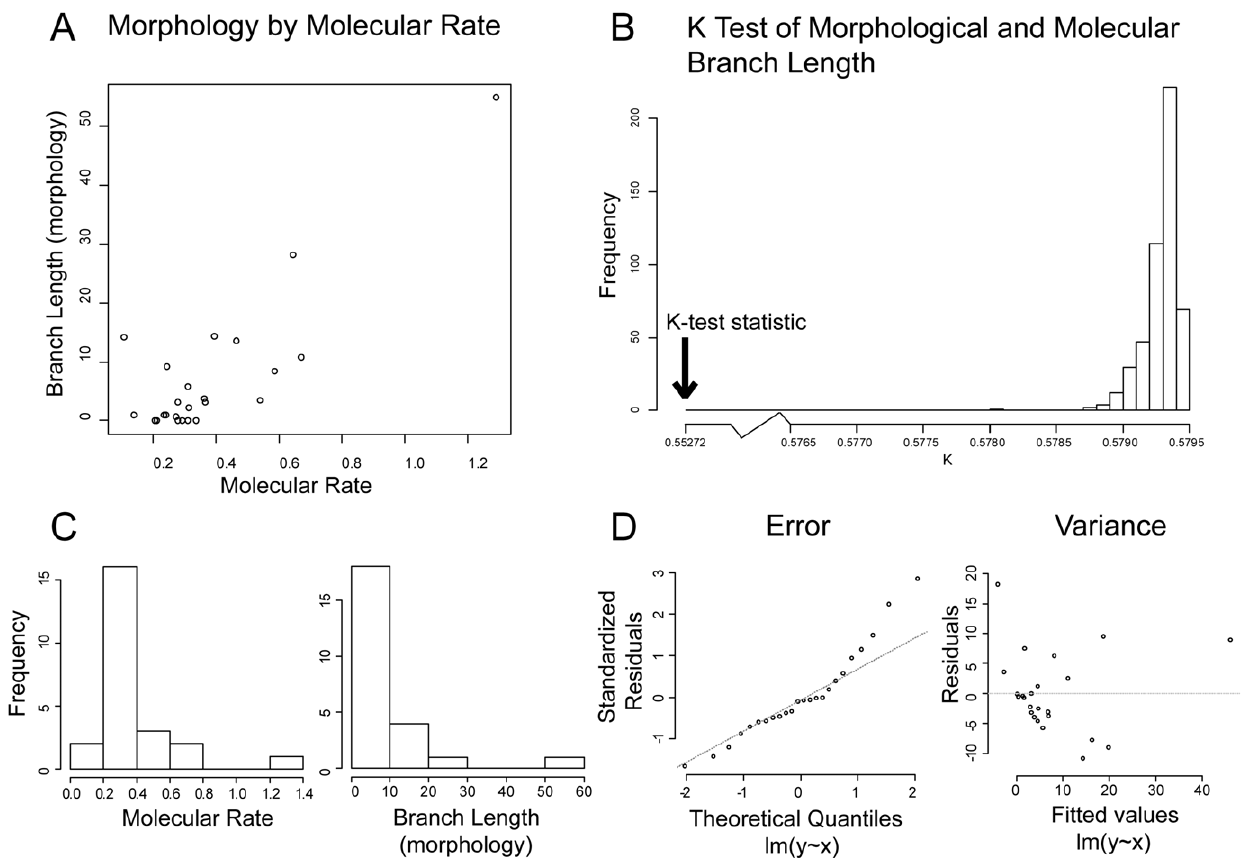
Figure 4. Graphical summary of molecular rate and morphological branch length variation. ( A ) Individual node comparison of molecular rate (pairwise sequence divergence / million years) versus morphological branch length (steps required under parsimony). ( B ) K-tree null distribution, with test-statistic indicated by arrow. ( C ) Distribution of molecular rate (left) and morphological branch length (right) variation. ( D ) Graphical summary of linear model assumptions: non-linearity of error (left) and heterogeneity of variance (right).